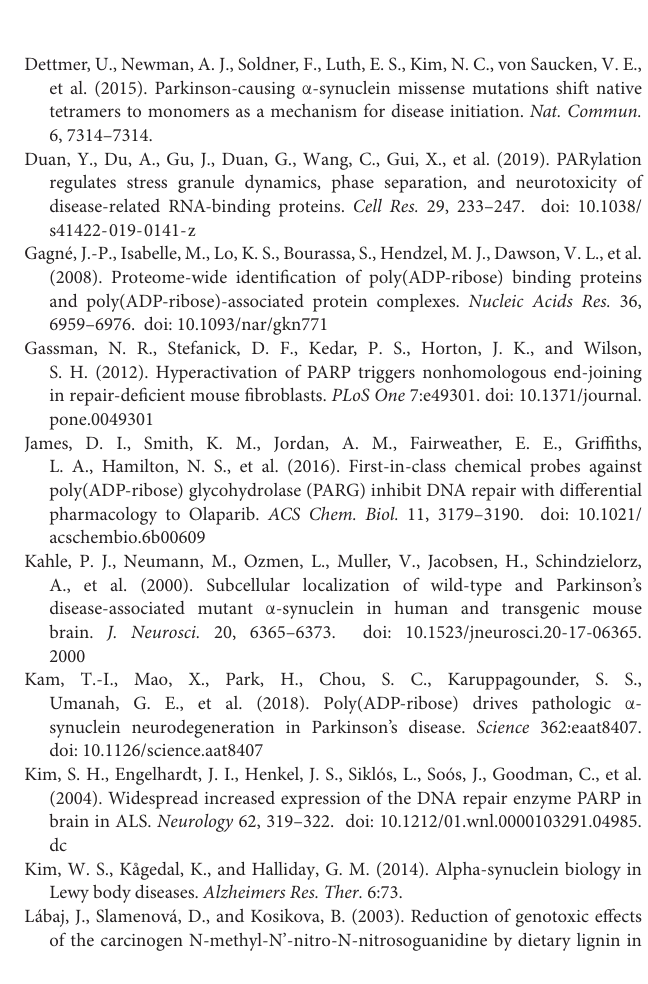
Supplementary Figure 2 | Characterization of PAR and p α Syn expression in murine brain sections. Representative images of endogenous PAR (a) and p α Syn (b) levels in sagittal brain sections from B6C3F1/J (top panel) and M83 Tg (bottom panel) mice at three different age groups (8, 12, and 17 months). (c) PLA on PAR-p α Syn (left) and PAR-PAN- α Syn (right) sagittal brain sections from M83 Tg mice at 18 months of age. All sections were 10 µ m thick and all images were captured using a Li-COR ODYSSEY CLx scanner. Supplementary Figure 3 | Cerebellum PLA and A53T dot blot. (a) PLA and DAPI signal from cerebellum sections derived from a control “non-MSA” patient. (b) Standard immunostain of adjacent cerebellum sections from a control patient showing p α Syn and DAPI signal. Images were captured using Zeiss Axio Widefield (20 × /0.8) microscope. (c) Representative PAR immunodot blot to assess PAR- α Syn A53T binding. Signal intensity was normalized to α Syn WT signal. Histone H4 and BSA were used as positive and negative controls for PAR binding, respectively. (d) Chemical structure of PAR-dimer used in molecular docking studies. Supplementary Table 1 | Antibody information. Supplementary Table 2 | Animal information. Supplementary Table 3 | Patient information. Supplementary Table 4 | Microscopy